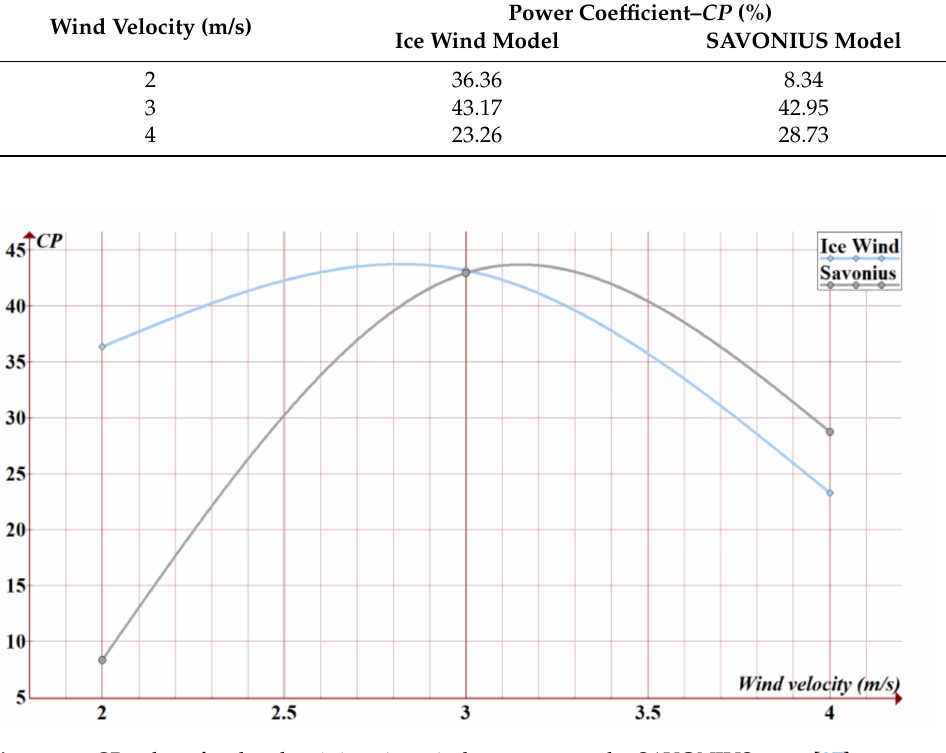
Figure 20. CP values for the aluminium ice wind rotor versus the SAVONIUS rotor [87]. The average power coefficient values were 34.26% for ice wind rotor and